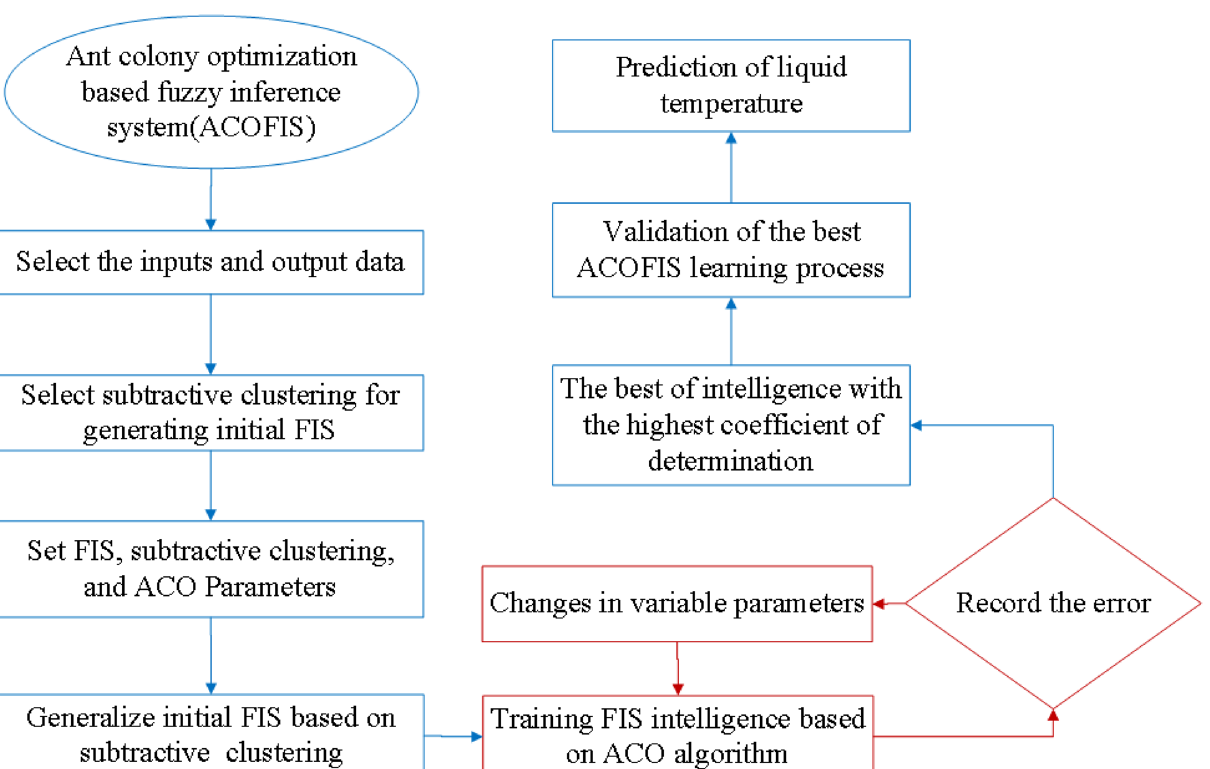
Figure 9. Flowchart for ACOFIS method, including ACO training part and generation of the FIS